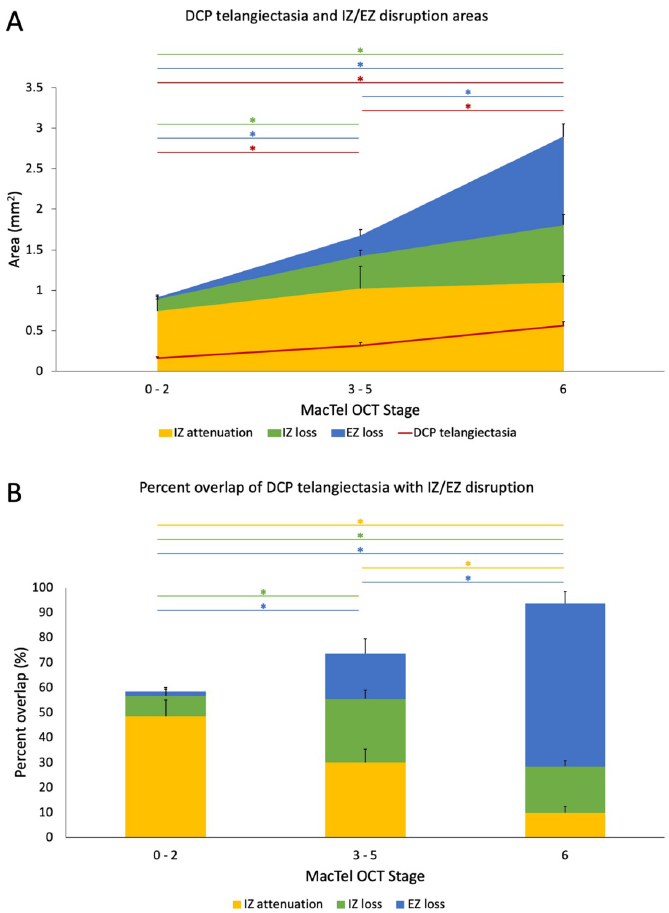
Fig 3. Areas and overlaps of DCP telangiectasia with photoreceptor defect parameters across MacTel OCT stage groups. MacTel eyes were classified by pooling OCT-based severity stages into early (Stages 0–2), moderate (Stages 3–5), and advanced (Stage 6). (A) Total area of IZ attenuation (yellow), IZ loss (green), EZ loss (blue), and DCP telangiectasia (red) with MacTel OCT stage. (B) Percent overlap of DCP telangiectasia with IZ attenuation (yellow), IZ loss (green), and EZ loss (blue) with MacTel stage. Generalized estimating equations were used to adjust for the contribution of two eyes from the same patient and differences between groups were compared using post-hoc pairwise tests with Bonferroni correction. Error bars represent 1 SE. Asterisks indicate statistically significant differences ( p < 0.05) between groups.